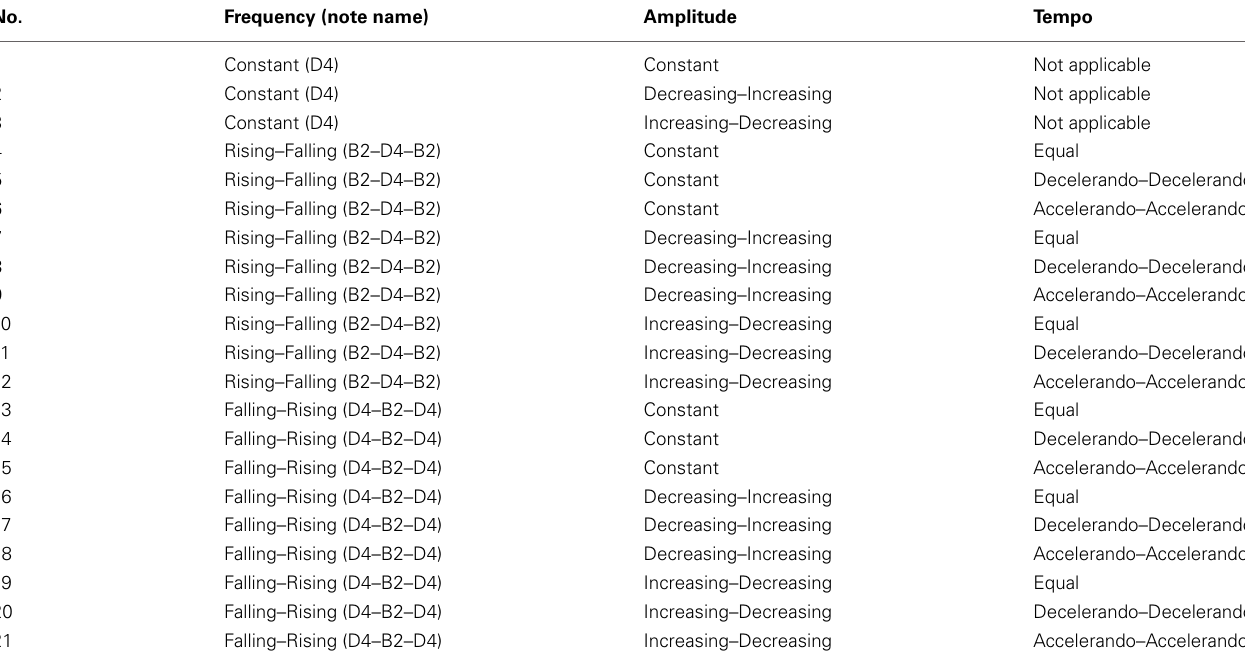
Table 1 | Overview of experimental sound